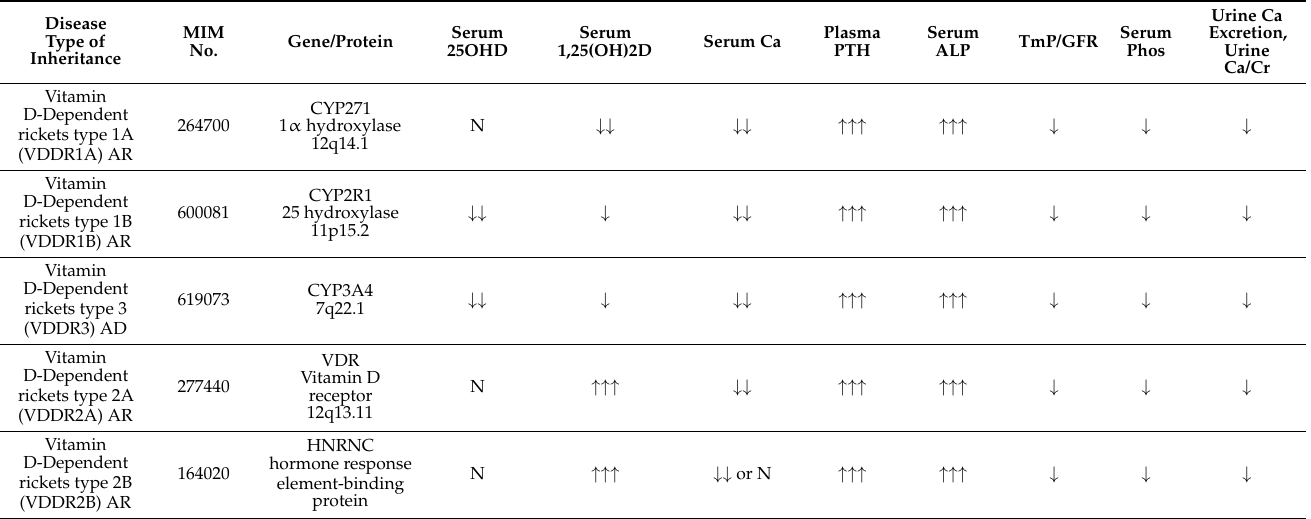
Table 1. Genetic mutations in Vitamin D pathway leading to